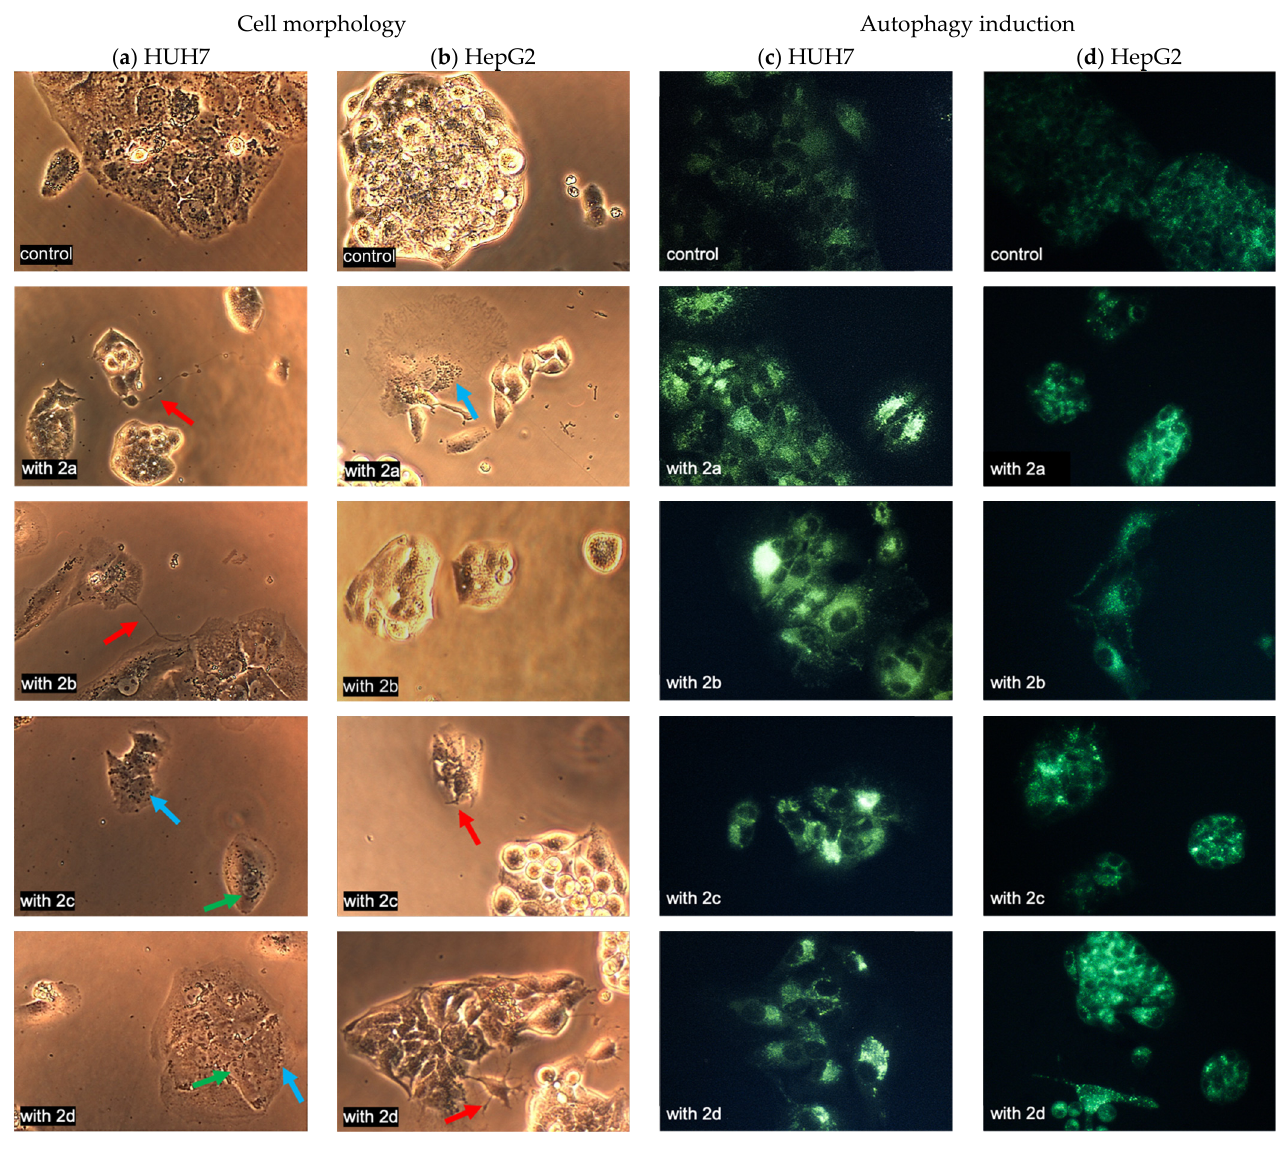
Figure 5. Left panel: Morphology of ( a ) HUH7 and ( b ) HepG2 cells after incubation for 72 h with tested compounds 2a – 2d applied at their IC 50 (shown in Table 1). Changes in morphology are indicated by arrows in the figures: the red arrow indicates the cytoplasmic linkages, the green arrow indicates abnormal cell nuclei, and the blue arrow indicates swellings of the cell’s cytoplasm. Right panel: Induction of autophagy in ( c ) HepG2 and ( d ) HUH7 cells after incubation for 72 h with tested compounds 2a – 2d applied at their IC 50 (shown in Table 1). The first row of images shows control cells, while the following figures show autophagosomes formed after treatment with the tested compunds. Images were taken using an Olympus IX70 microscope at 150× magnification.